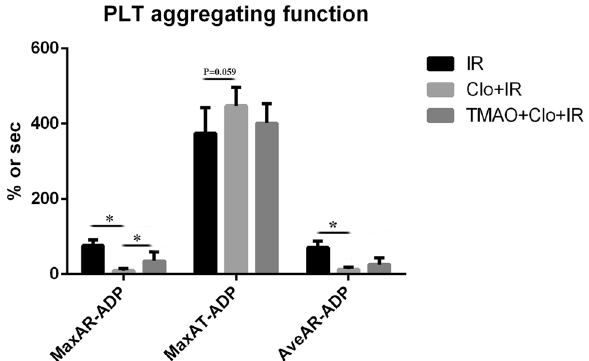
Figure 3. Clopidogrel inhibited platelet aggregation, and its effects could be partially suppressed by TMAO. * P < 0.05.